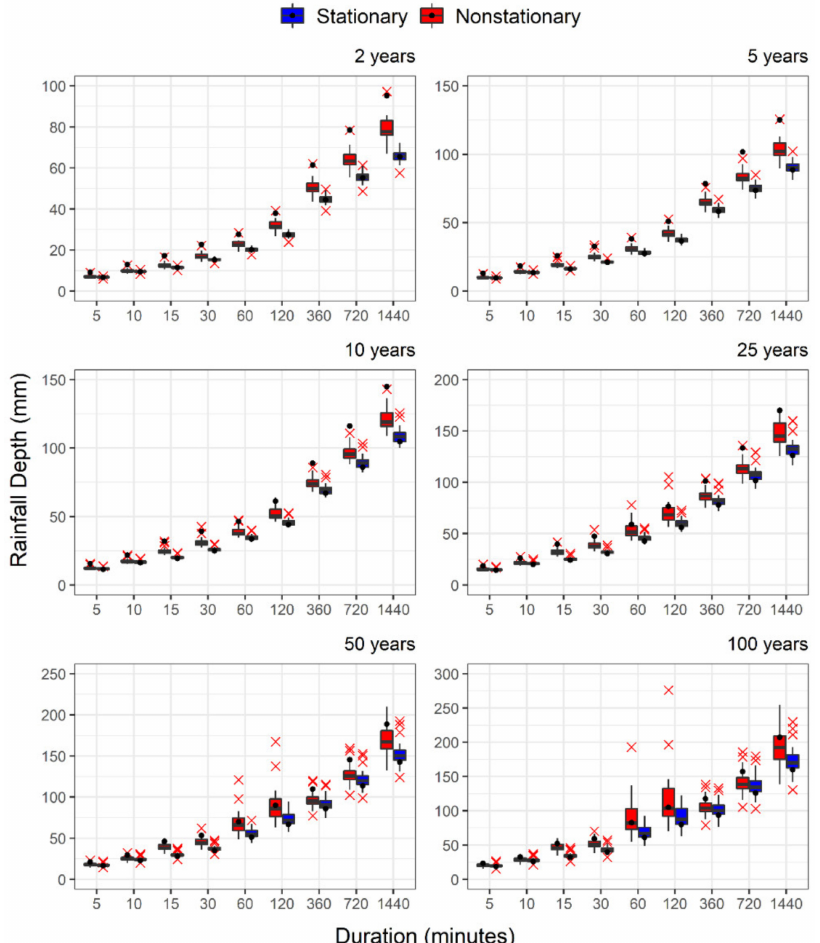
Figure 6. Rainfall depth estimation for different return periods and GCM models for the Moncton station (Representative Concentration Pathways (RCP) 8.5 emission scenario). Black point represents the rainfall depth estimated with the multimodel median ensemble. Red x represents the models in which results produce